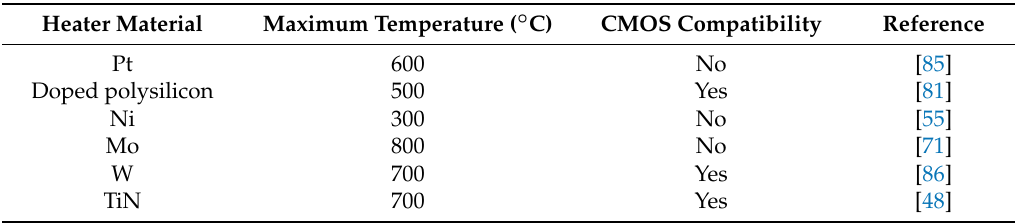
Table 3. Comparison of maximum temperature and complementary metal oxide semiconductor (CMOS) compatibility among various heater materials.